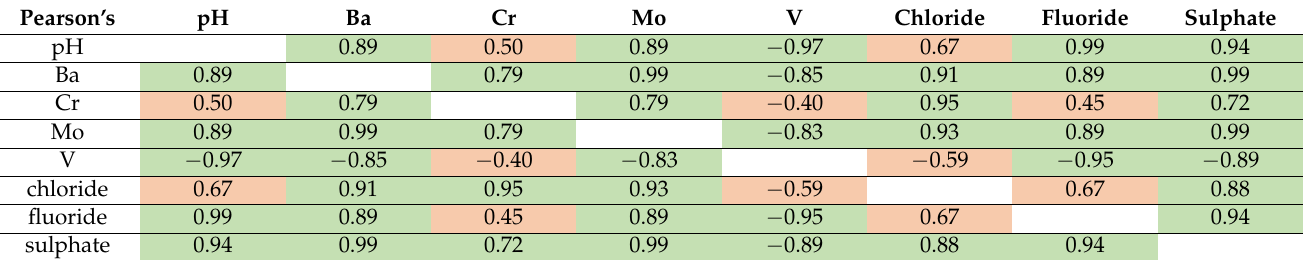
Table 4. Pearson’s correlation coefficient based on the leachate concentrations in fractions 2 to 7. Green is a strong correlation, orange is a medium correlation.